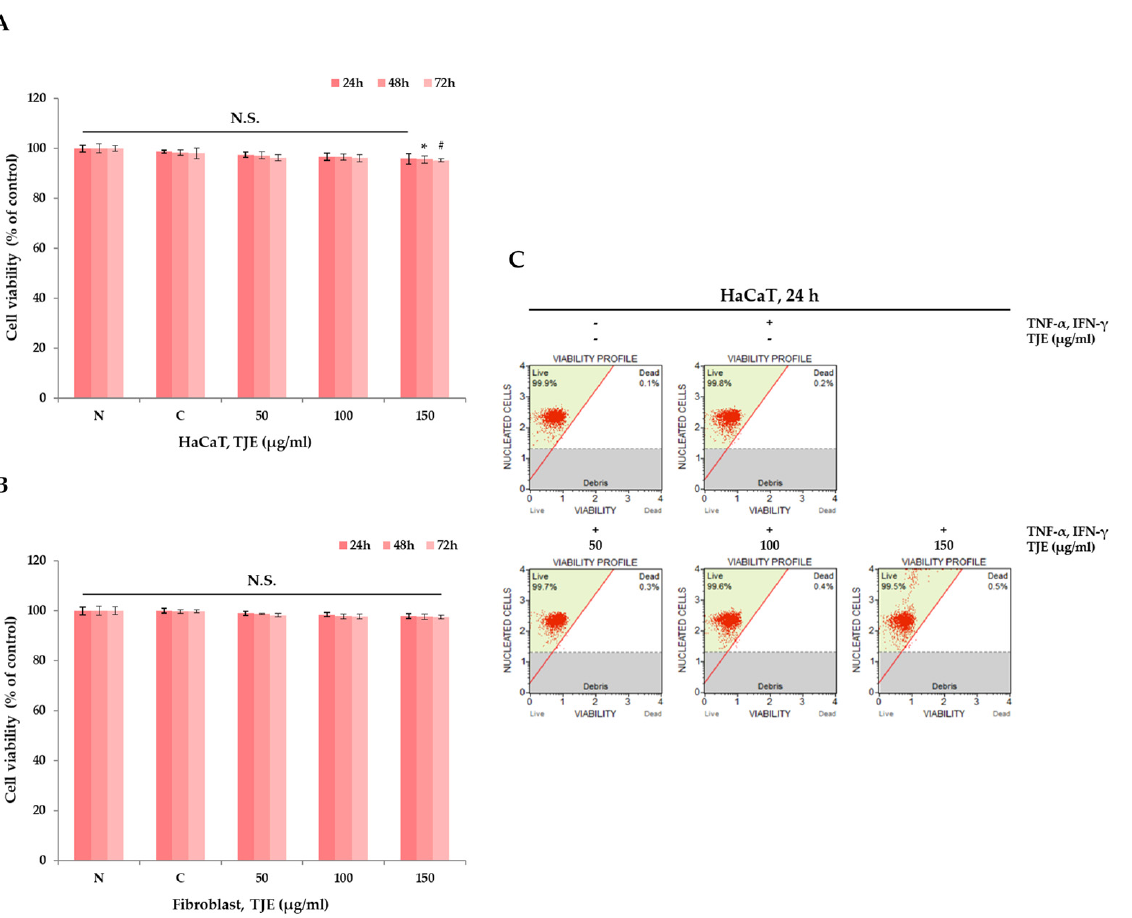
Figure 2. ( A ) Cell viability was measured by MTT assay. HaCaT keratinocytes were treated with variable concentrations of TJE (0-150 μ g/mL) and certain cytokine (TNF- α (10 ng/mL) and IFN- γ (10 ng/mL)) for 24-72 h. ( B ) Cell viability was measured by MTT assay. Dermal fibroblasts were treated with variable concentrations of TJE (0-150 μ g/mL) and certain cytokine (TNF- α (10 ng/mL) and IFN- γ (10 ng/mL)) for 24-72 h. ( C ) Cell viability assay using flow cytometry. The statistical analysis of the data was carried out by use of a t -test. * ,# p < 0.05 (each experiment, n = 3). N.S.; not significant. N: negative control, C: positive control (only TNF- α (10 ng/mL) and IFN- γ (10 ng/mL) treated